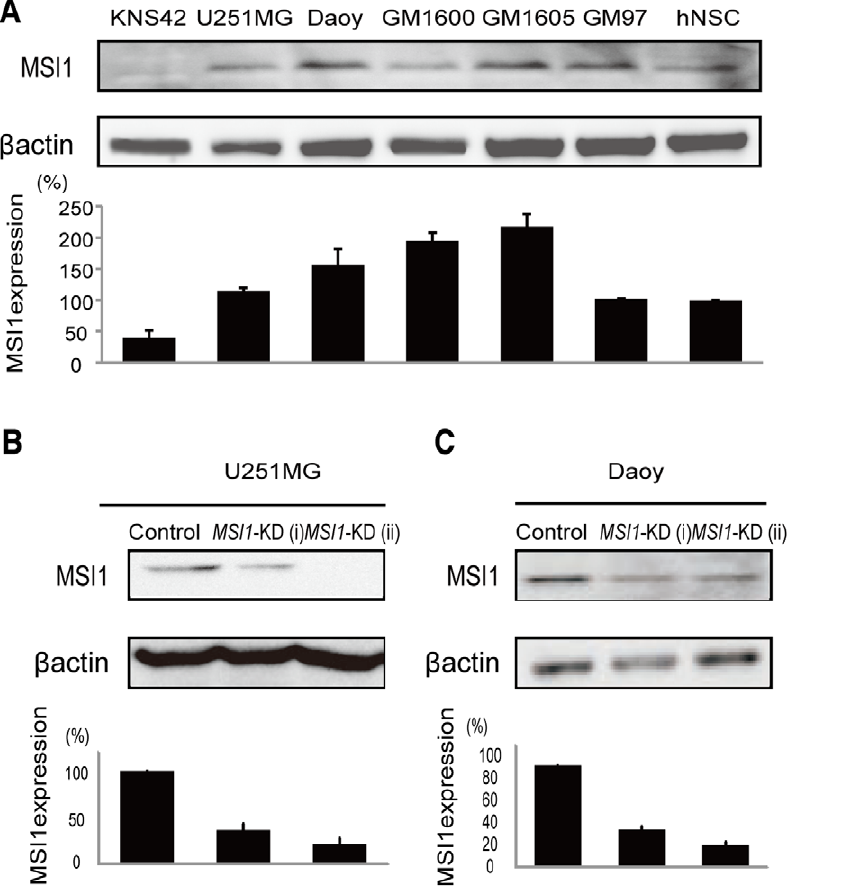
Figure 1. MSI1 expression in glioblastoma cell lines, medulloblastoma cell lines, and low-passage cells from glioblastoma patients. (A) Immunoblots showing the MSI1 expression in human glioblastoma cell lines (U251MG, and KNS42), low-passage glioblastoma cells obtained from patients GM97, GM1600, GM1605, and a human medulloblastoma cell line (Daoy). (B and C) The selective depletion of MSI1 protein by treatment with shRNAs in U251MG cells (B) and Daoy cells (C). b -actin was used as a loading control in all the experiments.